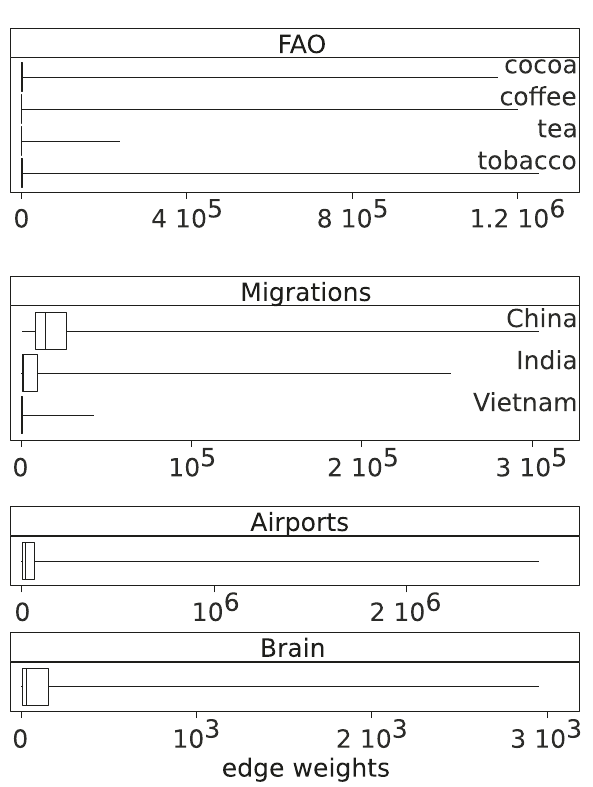
∣ V ∣ indicates the number of nodes and ∣ E ∣ the number of edges in the networks. Multiple edges have been aggregated and loops